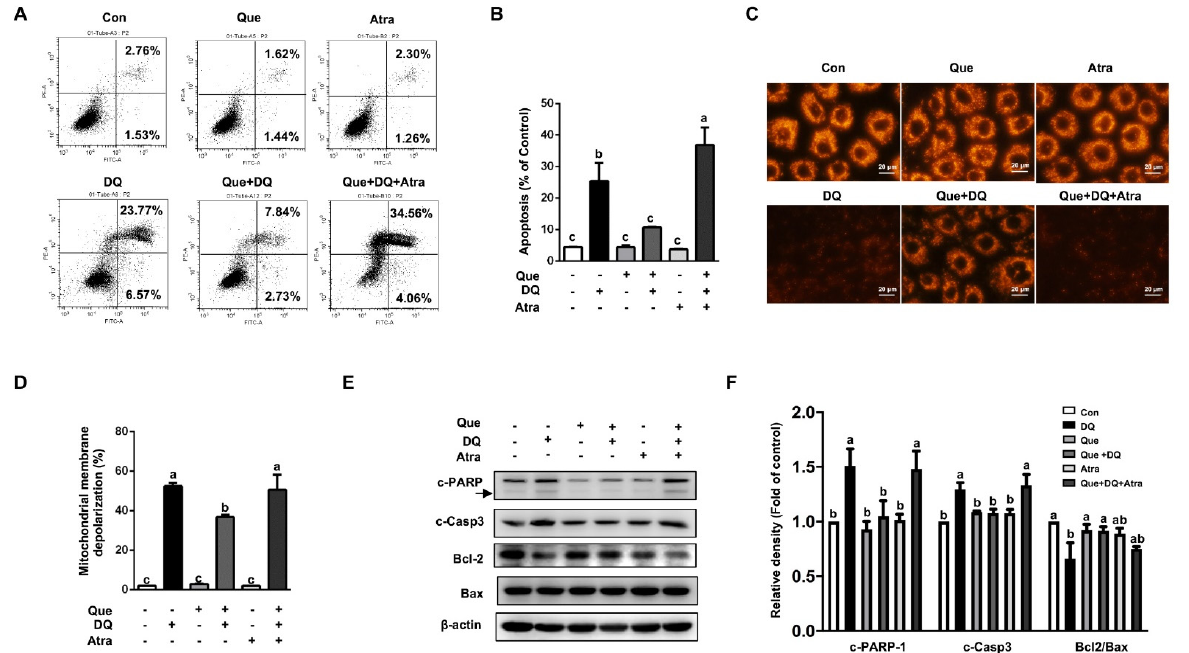
Figure 6. Quercetin protected against diquat-induced apoptosis in a Nrf2-dependent manner. IPEC-1 cells treated as described in Figure 5. ( A , B ) Cell apoptosis, ( C , D ) mitochondrial membrane depolarization, and ( E , F ) protein abundances of c-PARP, c-Casp3, Bcl2, and Bax were determined. Representative experimental results were repeated in three independent experiments and values are means ± SEMs, n = 3. Means without a common letter are considered as a significant difference, p < 0.05.